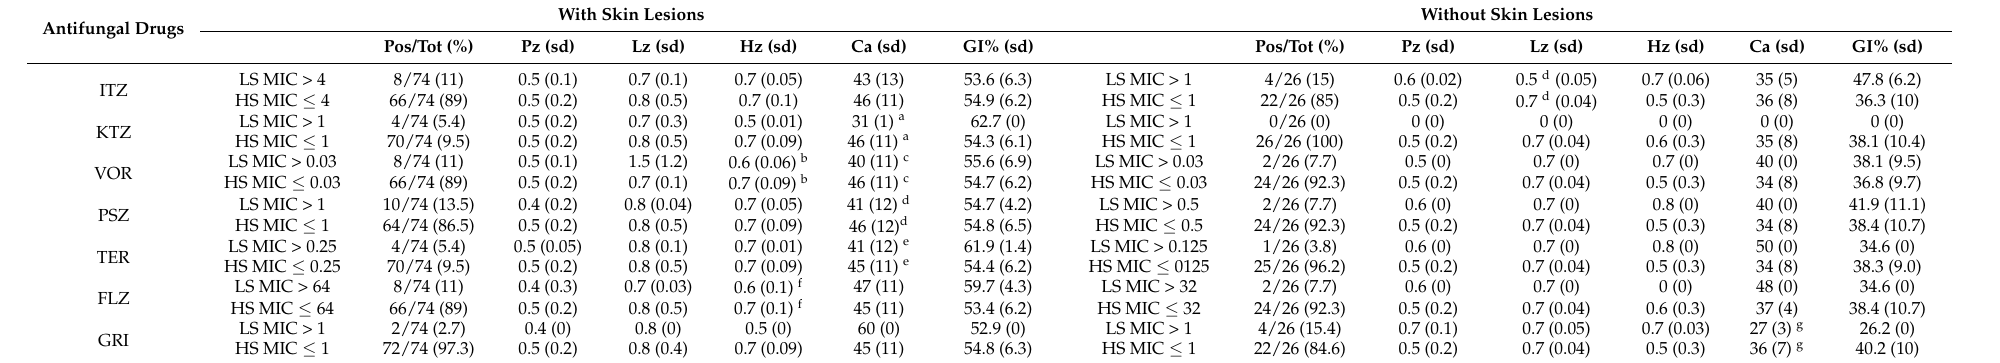
Table 3. Virulence factors of Low (MIC > MIC 90 ) and High (MIC ≤ MIC 90 ) drug susceptible strains of Microsporum canis . Virulence factors are reported as mean value of phospholipase (Pz), lipase (Lz), hemolytic (Hz) and catalase (Ca; unit = mm) activities, and thermotolerance (GI) with standard deviation (sd) in